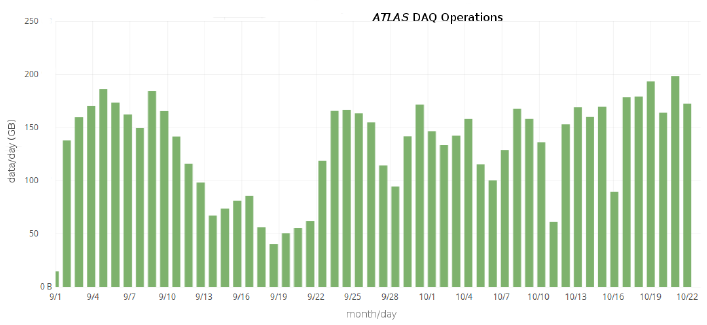
Figure 6. Rate of monitoring data updates during few minutes of typical ATLAS data taking period